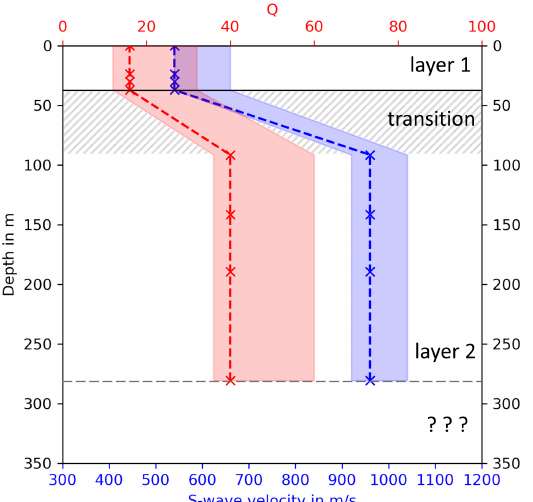
Figure 11. Two-layer model derived by fitting observed and mod- eled amplitude decays. The best model parameters ( c S and Q S ) for the two layers are found by performing a grid search to optimize the fitting of amplitude decays of signals < 4 and > 4Hz separately. The depths of the layer interfaces are obtained by assuming a pene- tration depth of surface waves of λ/ 3. The transition between layer 1 and layer 2 and the area below layer 2 is unclear, due to the lack of amplitude decays of signals between 3.5 and 4.85Hz and below